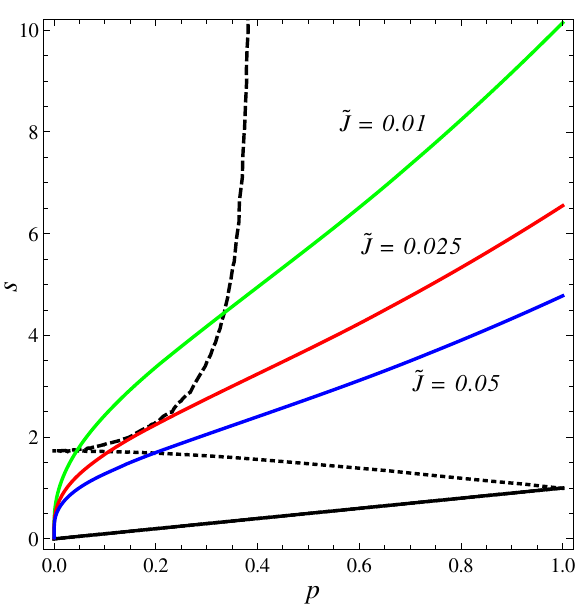
curves − α( J ) at constant M and the curves of constant M in the ( p , s ) space are depicted on Fig. 17 and Fig. 18, respec- tively. The behavior of the stability curves is almost identical to the one of the Kerr–Rényi